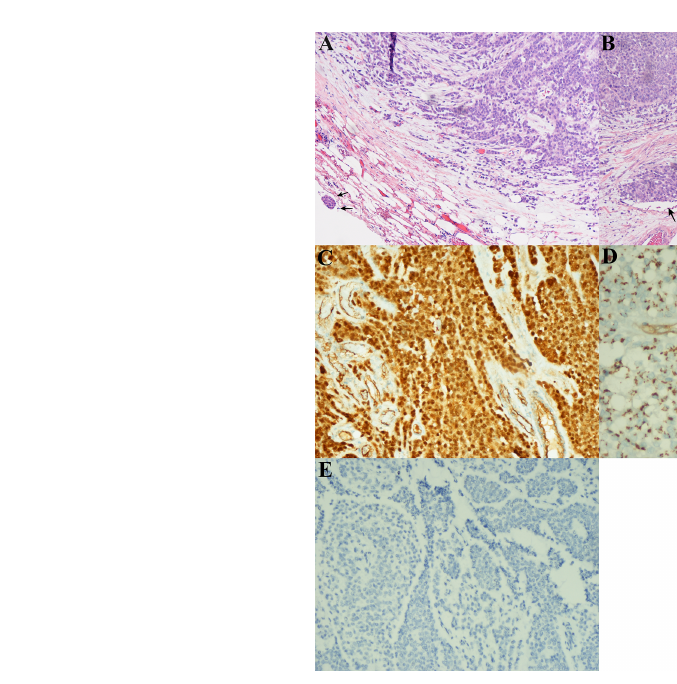
FIGURE 2 | Microscopic and immunohistochemical fi ndings in peritoneal lesions of the metastatic solid-pseudopapillary neoplasms (SPN). (A) , The tumor had a heterogeneous growth with predominantly pseudopapillary pattern (hematoxylin-eosin, original magni fi cation ×200). Note the capsular invasion (black arrow). (B) , Vascular invasion (black arrow). (C) , Nuclear positivity for b – catenin. (D) , Dot-like paranuclei positivity for CD99. (E) , Negative for chromogranin A (CgA) expression in